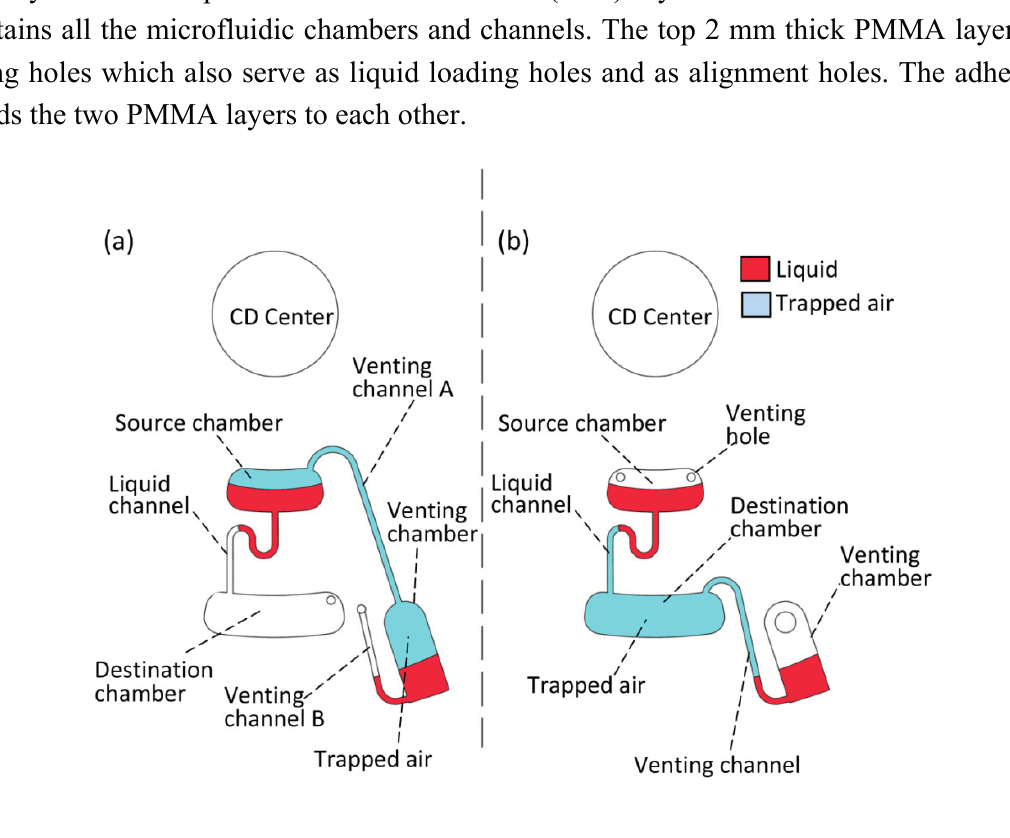
Figure 1. PLV designs, ( a ) S-PLV design where the venting chamber is connected to